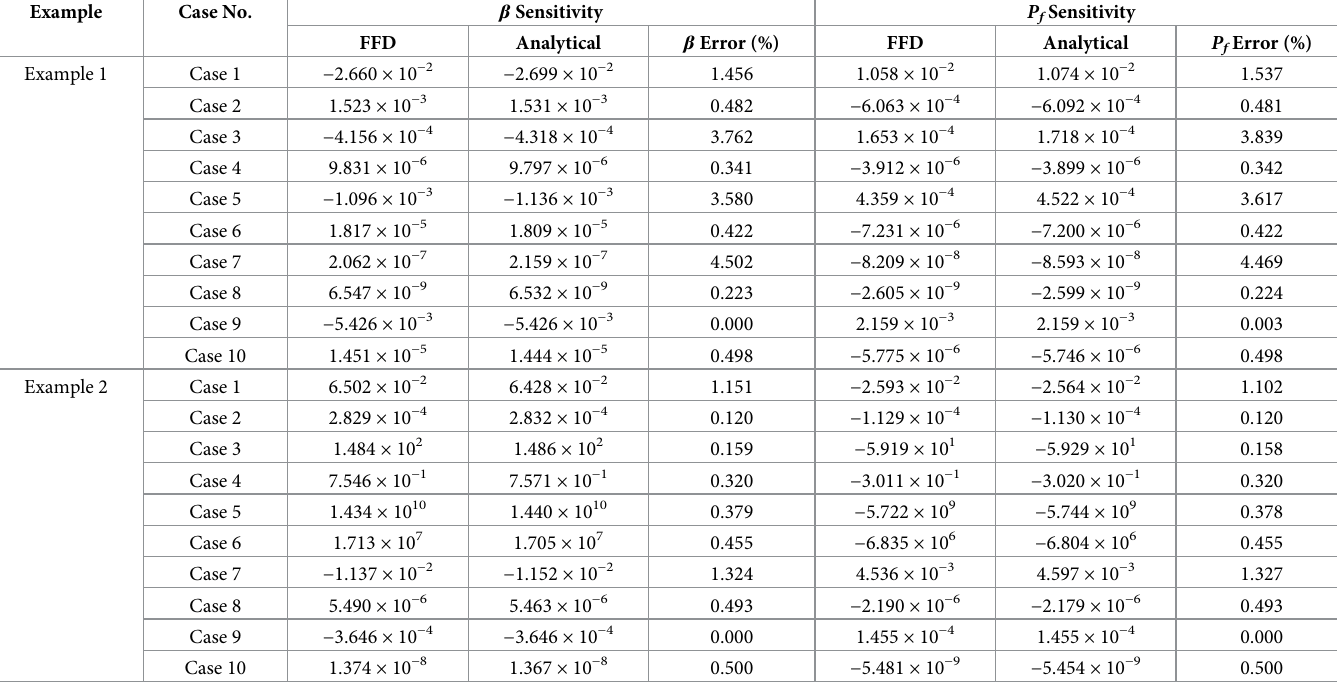
Table 5. Comparison between the results obtained from analytical calculations and the FFD method. Example Case No.